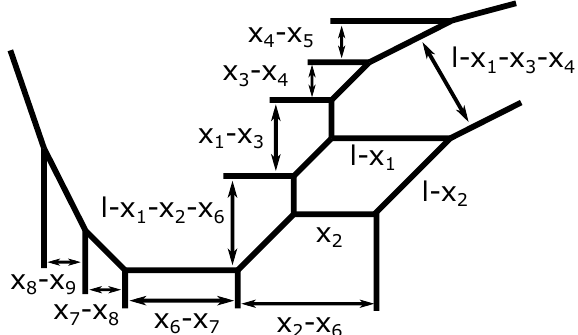
Figure 56. The web diagram of dP 9 which corresponds to the E-string whose compact surface is contained in the lower-right diagram in figure 55. l is the hyperplane class of P 2 and x i ( i = 1 , · · · , 9) are the exceptional curve classes. A curve class next to a double arrow implies that the length of the double arrow is related to the volume of the curve class.